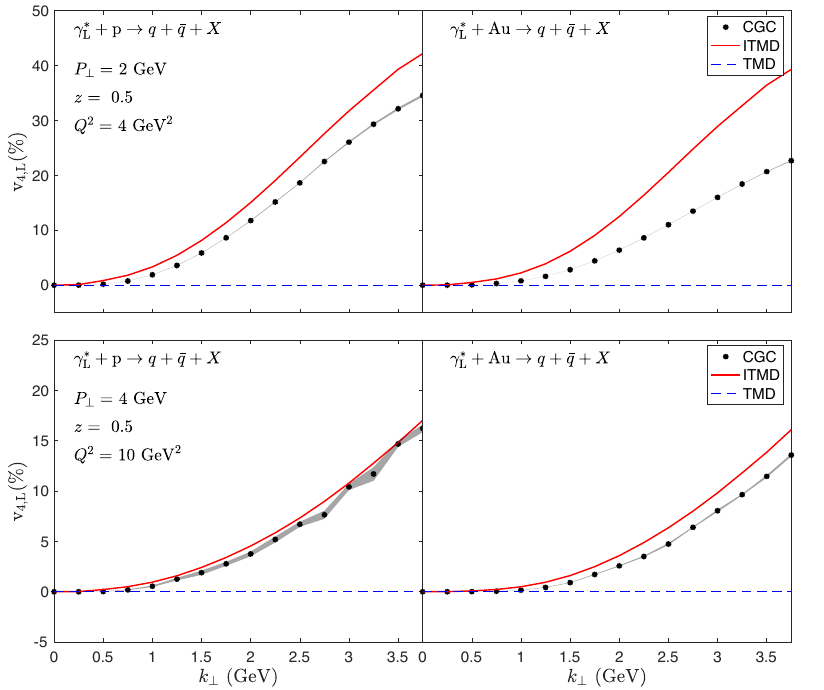
Figure 13 . Quadrangular anisotropy v 4 in the angle φ for production of quark anti-quark pairs in γ ∗ + p (left) and γ ∗ + Au (right) scattering. The grey band shows the numerical uncertainty of the T T CGC